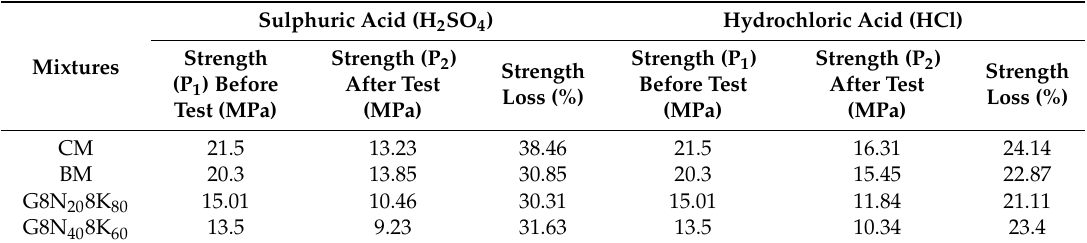
Table 8. Residual strength calculation after acid attack on the 28 day samples.